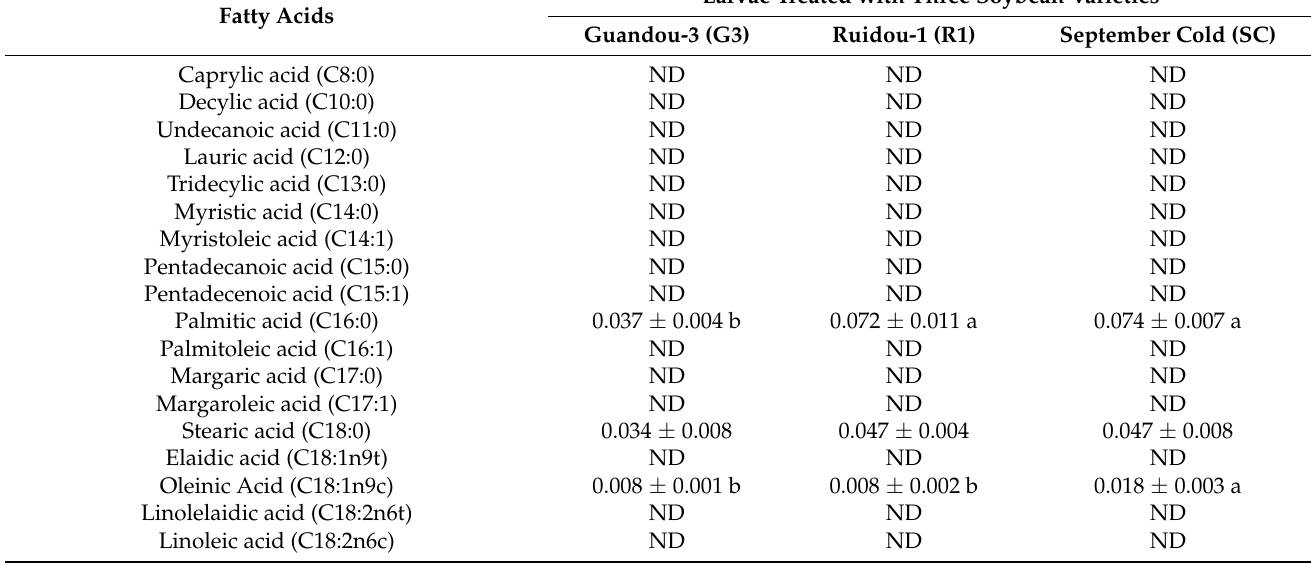
Table 3. The content (g/100 g FW) of fatty acids in C. bilineata tsingtauica larvae fed on different soybean